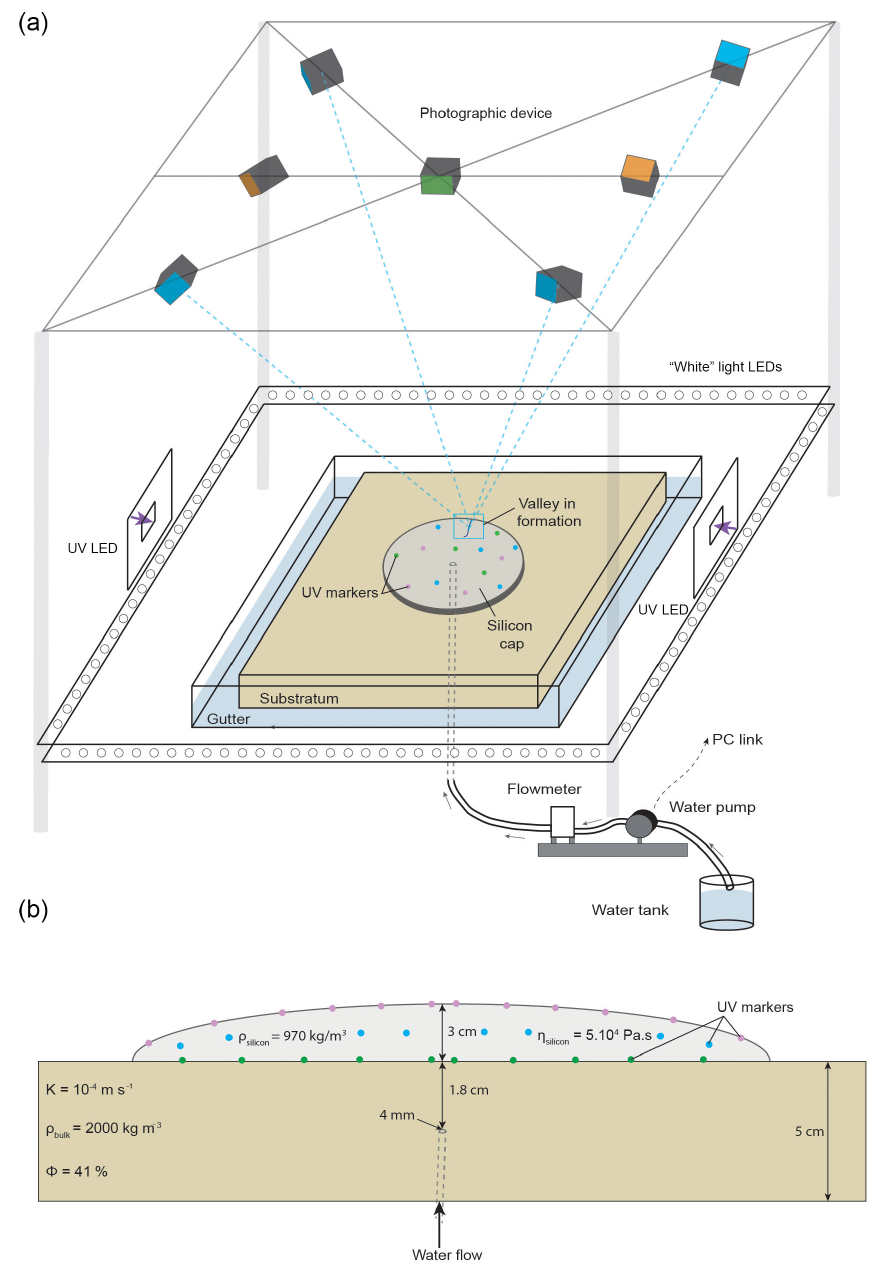
Figure 1. Description of the analogue device used in this study. (a) Overview of the analogue device. The analogue device consists in a 70cm long, 70cm wide, and 5cm deep glass box filled with saturated and compacted sand simulating the substratum. The ice sheet portion is simulated by a circular layer of silicon putty containing three levels of UV markers. Meltwater production is simulated by a central and punctual injection of pure water within the substratum. Five synchronized cameras placed above the silicon putty (in blue) focus on the tunnel valley system and are used to produce digital elevation models by photogrammetry. Another camera (in orange) takes overview photographs of the analogue device to follow the progress of the whole experiment. A last camera (in green) is positioned at the vertical of the silicon layer centre and is configured to take high-resolution photographs of the UV markers in black light (illuminated with two lateral UV LED lights). (b) Cross-sectional profile of the analogue device displaying the position of the UV markers and the physical characteristics of both the substratum and the silicon